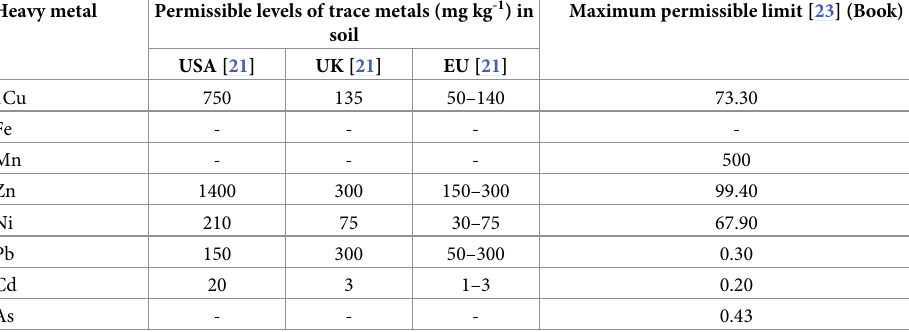
Table 6. Permissible levels of trace metals (mg kg -1 ) in soil from US, UK and EU irrigated with contaminated water and in agronomic crop (mg kg -1 ). Heavy